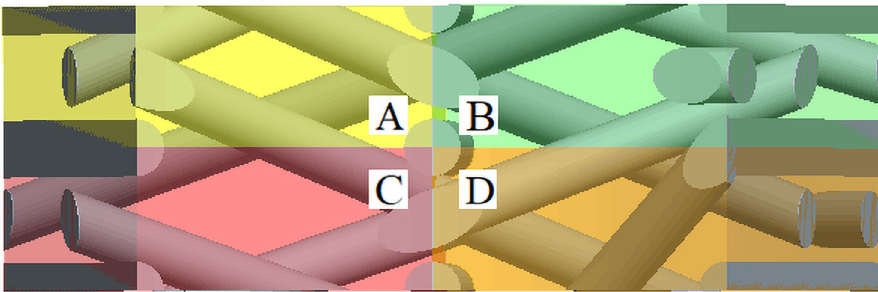
Fig 5. Cross-sectional view of internal unit cell matrix and fiber yarn.